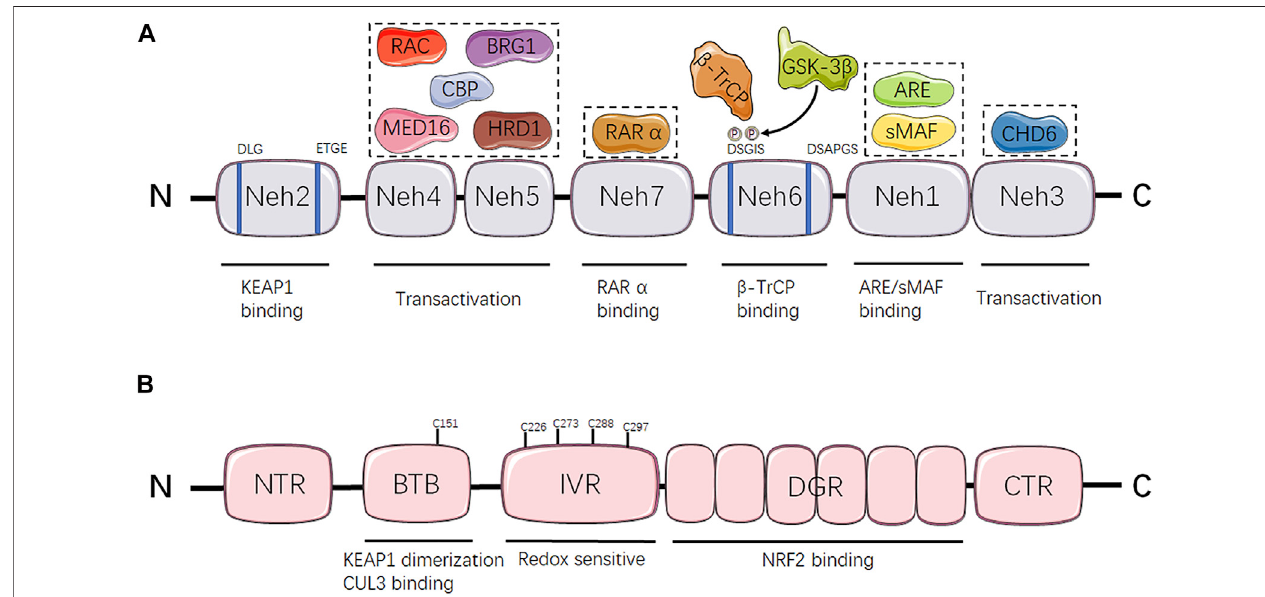
FIGURE 1 | Domain structure and function relationship of NRF2 and KEAP1. (A) Schematic representation of NRF2 structure. NRF2-interacting molecules are shown in dash line boxes and placed above their interacting domains. (B) Schematic representation of KEAP1 structure. Neh, NRF2-ECH homology; KEAP1, kelch-like ECH-associated protein 1; MED16, mediator complex subunit 16; HRD1: HMG-CoA reductase degradation 1 homolog; RAC, receptor-associated coactivator; BRG1, brahma-related gene 1; CBP, CREB binding protein; RAR α , retinoic acid receptor X receptor α ; GSK-3 β , glycogen synthase kinase 3-beta; β -TrCP, beta- transducin repeat-containing protein; sMAF, small muscle aponeurosis fi bromatosis; ARE, antioxidant response elements; CHD6, chromo-ATPase/helicase DNA binding protein 6; NTR, N-terminus region, BTB, Broad complex/Tramtrack/Bric-a-brac; CUL3, Cullin 3; IVR, intervening region; DGR, double glycine repeat; NRF2, nuclear factor erythroid 2-related factor 2; CTR, C-terminus